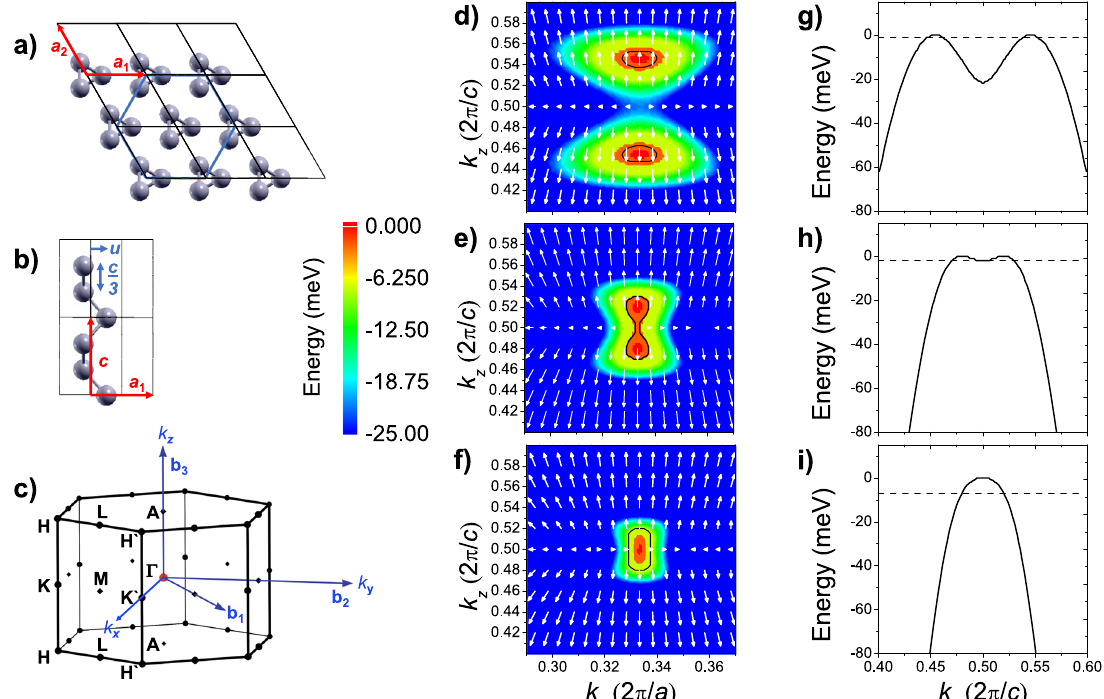
Fig. 3 Theoretical calculations of the band structure and the spin texture around the H-point for different pressures. a and b Schematic representation of the tellurium atomic structure with the hexagonal Bravais lattice vectors, a 1 , a 2 and c and the internal atomic position parameter u . The three tellurium atoms are placed at ( u , 0, 0), (0, u , 1/3) and ( − u , − u , 2/3) in units of the crystal lattice. c Reciprocal lattice ( b 1 , b 2 , and b 3 ) and cartesian ( k x , k y , and k z ) direction vectors of the hexagonal Bravais lattice as well as the special points. d – f Two-dimensional plot of the valence band in the k x × k z plane together for three pressure points: P < P c (sub fi gure d ), P ≈ P c (sub fi gure e ), and P > P c (sub fi gure f ) (further information in Supplementary Note 1). The white arrows display the calculated spin texture. The black line represents the Fermi contour for a hypothetical charge carrier density of 10 16 cm − 3 . g – i Electronic energy dispersion of the valence band along of the K-H-K path of the Brillouin Zone for the same pressure points. The dashed line represents the Fermi energy for the same charge carrier